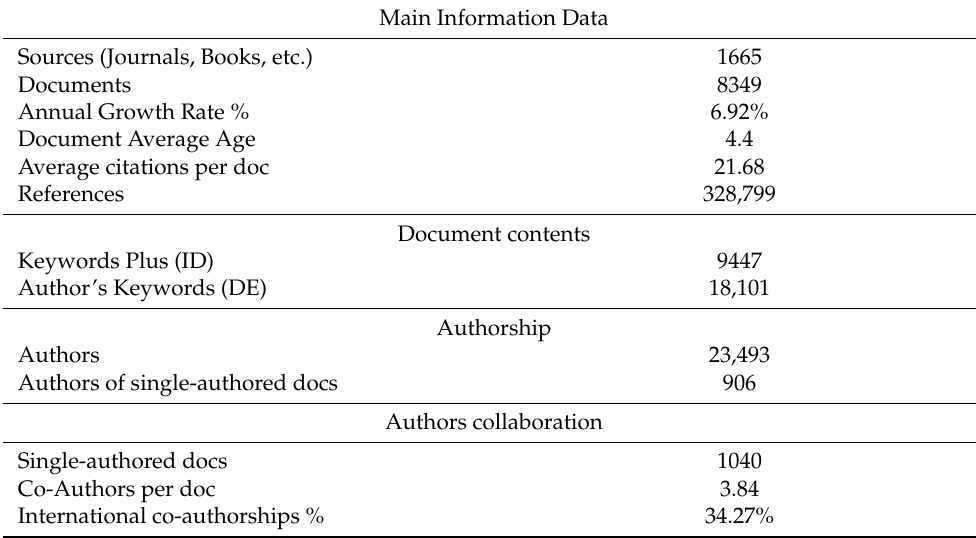
Table 1. Main information about the dataset.